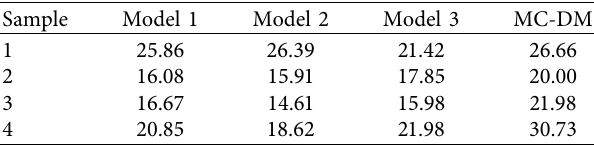
Table 2: PSNR (dB)